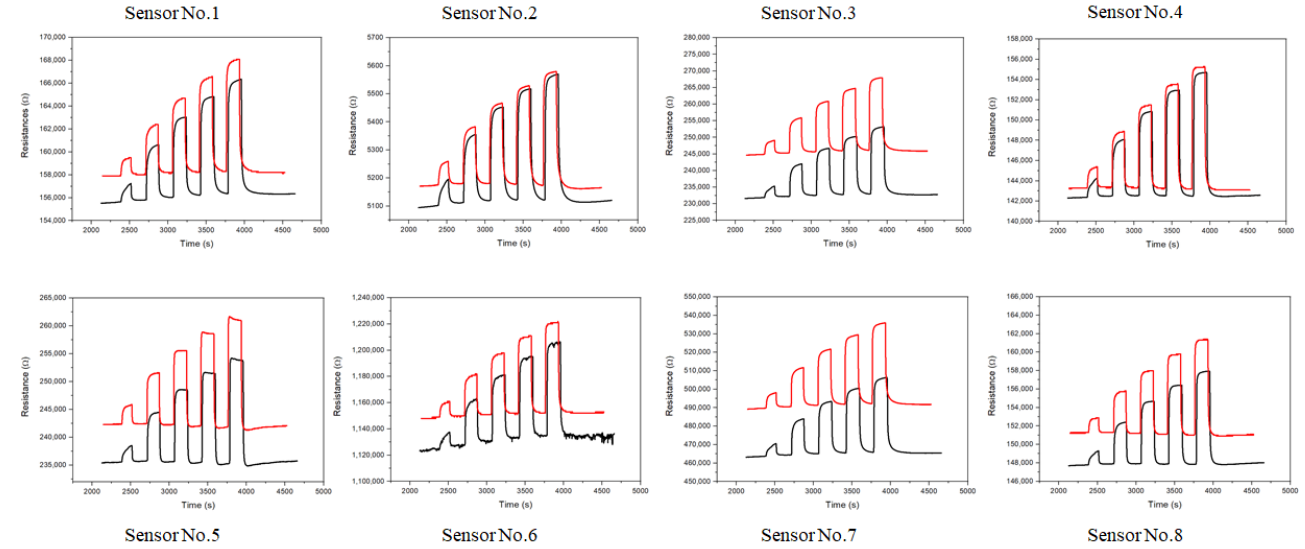
Figure 4. Response profiles of the nanostructured sensor array to hexane vapors of different concentrations with HCD (red curves) and KMM (black curves). The hexane vapor concentration range: 300 ppm~1500 ppm. Sensor array: ( 1 ) HDT-Au 2nm , ( 2 ) BDT-Au 2nm , ( 3 ) ODT-Au 5nm , ( 4 ) PDT-Au 5nm , ( 5 ) NDT-Au 2nm , ( 6 ) MUA-Au 2nm , ( 7 ) MUA-Au 5nm , and ( 8 ) HDT-Au 5nm .